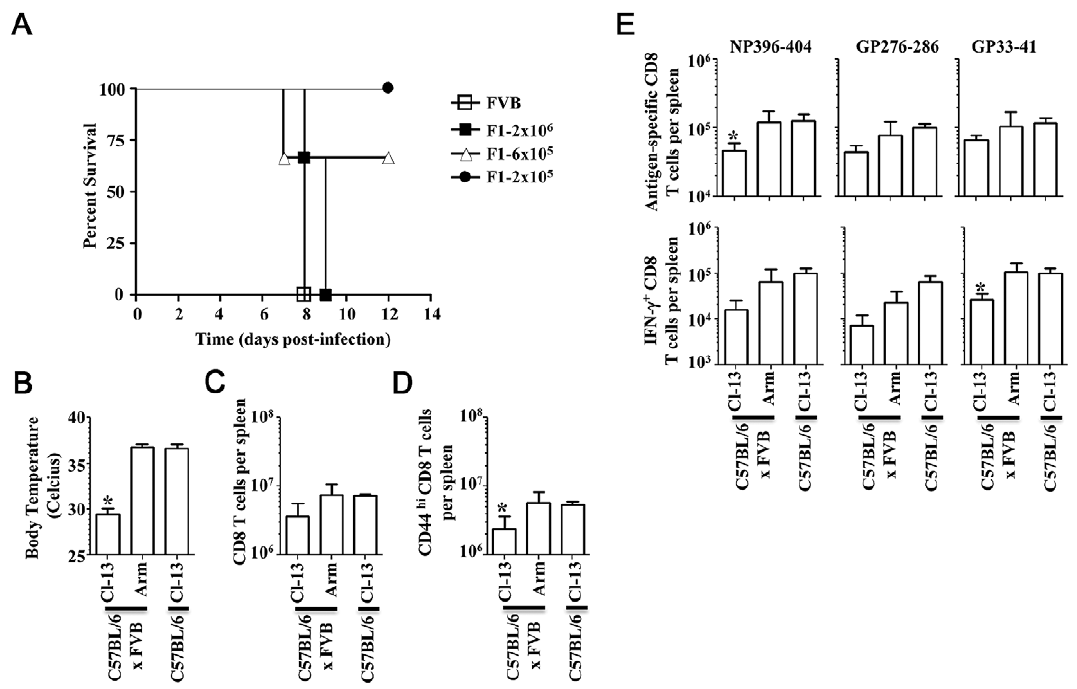
Figure 9. FVB 6 C57BL/6 F1 hybrids succumb to hemorrhagic disease while retaining H-2D b restricted T cell response to LCMV infection. A) FVB mice were infected with 2 6 10 6 PFU LCMV-13 and F1 hybrids were infected with the indicated doses of LCMV-13 and monitored for survival (n=3). B) C57BL/6 or F1 hybrid mice were infected with the indicated virus and body temperature was assessed day 7 post-infection (n=5). C–D) Splenic T cell numbers were assessed day 7 post-infection. E) Virus specific CD8 T cell numbers in the spleen as assessed by MHC pentamer stain (top) and IFN- c production (bottom) after stimulation with the indicated peptides. Data are presented as the mean + / 2 standard deviation (*, p , 0.05. t-test). doi:10.1371/journal.ppat.1003073.g009 FVB 6 C57BL/6 F1 and FVB H2-D b transgenic mice are resistance to persistent Theiler virus infection and development